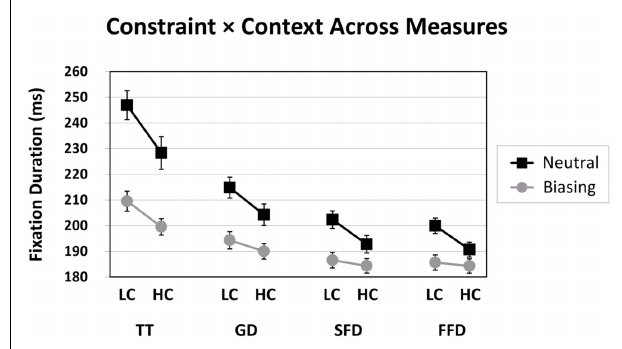
FIGURE 2 |The relation between Constraint (LC, HC) and Context (Neutral, Biasing) across average fixation time measures (ms), with SE bars, from longest to shortest durations:TT, GD, SFD, and FFD. LC, low constraint; HC, high constraint;TT, total fixation time; GD, gaze duration; SFD, single fixation duration; FFD, first fixation